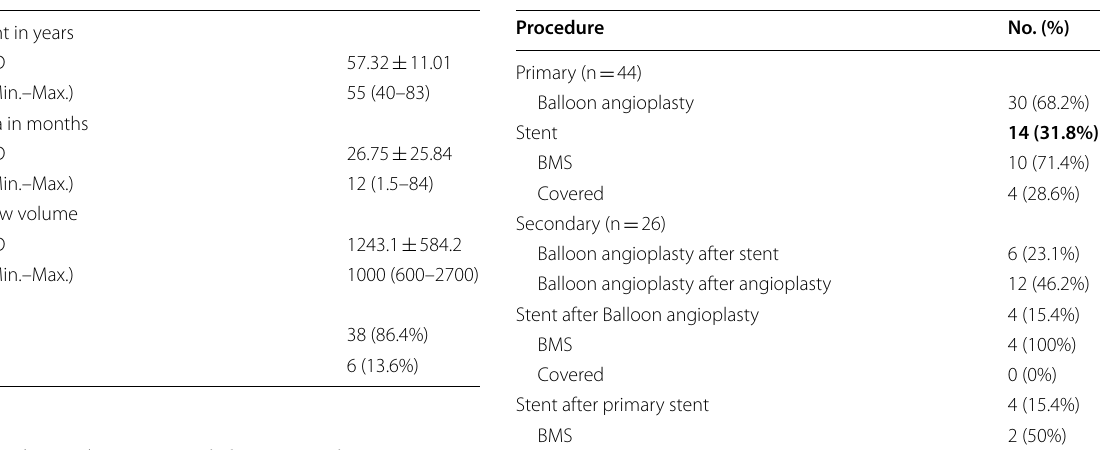
Table 1 Distribution of the studied cases according to different